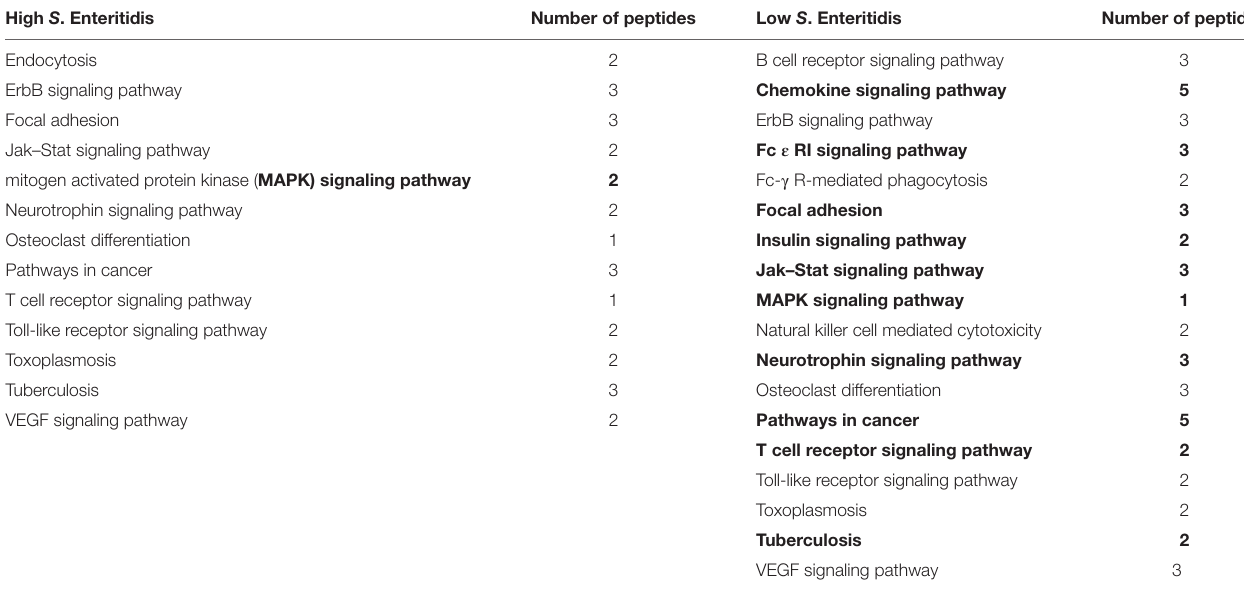
TaBle 4 | Kyoto Encyclopedia of Genes and Genomes (KEGG) pathways identified with the peptide array at the late stage infections in chickens with high and low levels of Salmonella Enteritidis colonization. high S . enteritidis